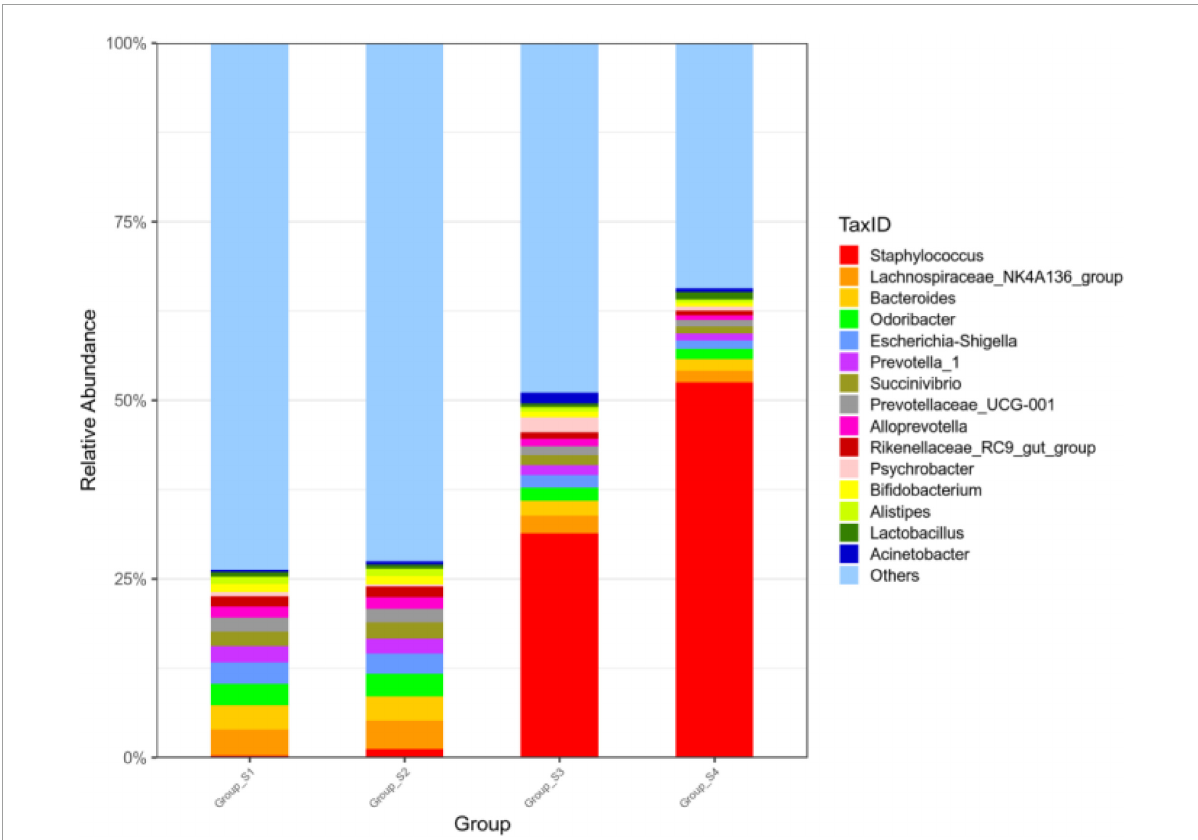
FIGURE2 Relative abundance of bacteria at the genus level of fermented mutton sausage during natural ripening (the 15 most abundant